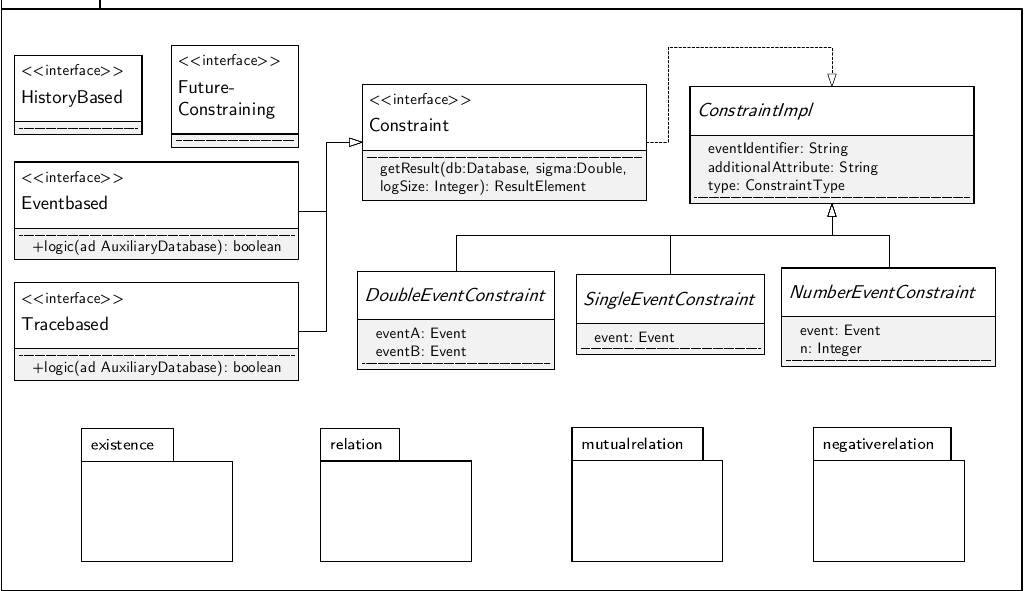
Figure 4. The package constraint